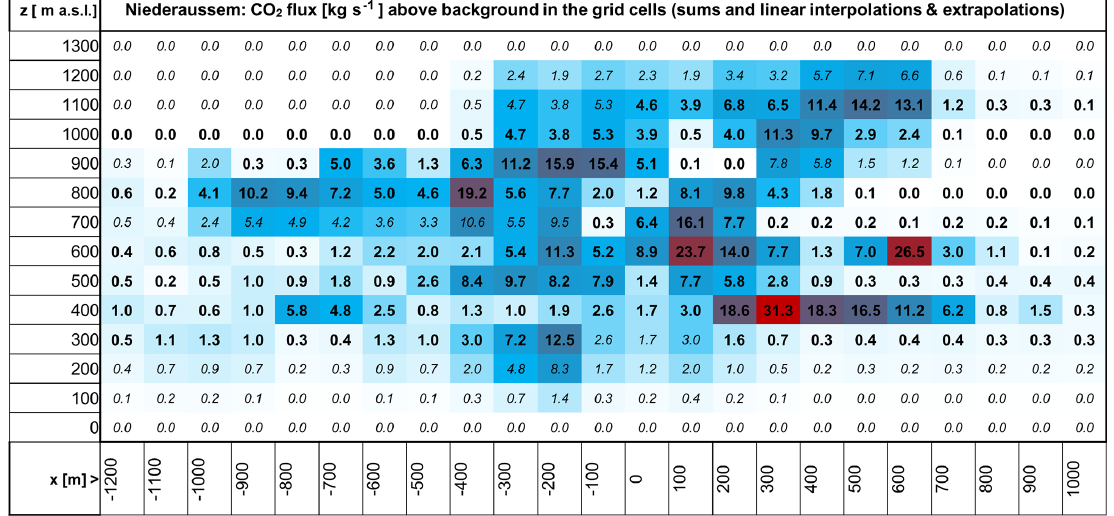
Figure 4. Example of results for the cells on a cross section. Shown is the direct CO 2 flux in the plume of Niederaußem (S1, same plume as in Fig. 3). Since the grid cells are not points, but areas filling 100 × 100m 2 (or more precisely, voxels of 100 × 100 × 1m 3 ), the values are not displayed as contour plots, but as pixels. The x and z coordinates are centred in the cells. The standard inter- and extrapolation were done with the methods described in the text. Cells with bold numbers [kgs − 1 ] contain measurements (20 points in the average), while the inter- and extrapolated cells are shown with smaller italic numbers.